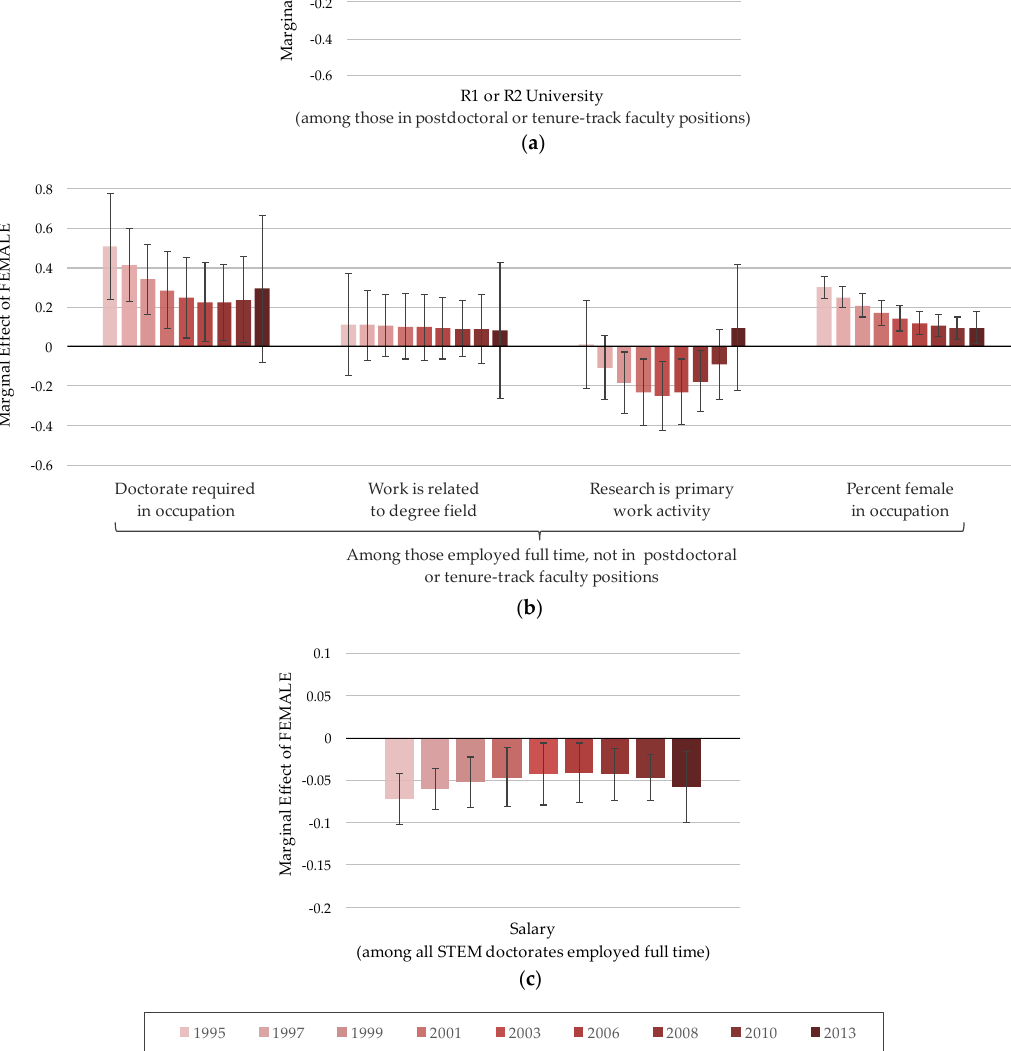
Figure 6. Average estimated marginal effects of FEMALE on the likelihood of: ( a ) employment at a R1 or R2 university (among STEM doctorates entering postdoctoral or tenure-track faculty positions);